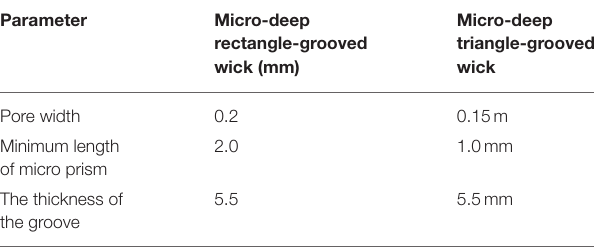
TABLE 5 | The parameters of the micro-deep grooved wick.